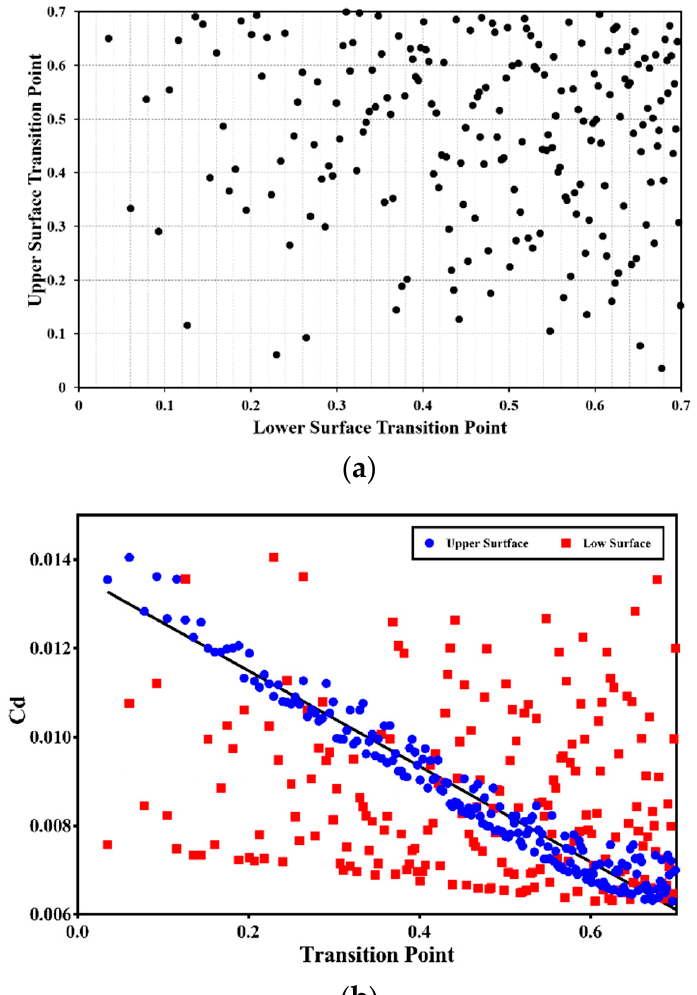
Figure 13. Monte Carlo sample points and aerodynamic results. ( a ) Monte Carlo sample points’ distribution; ( b ) Distribution of drag coefficient.